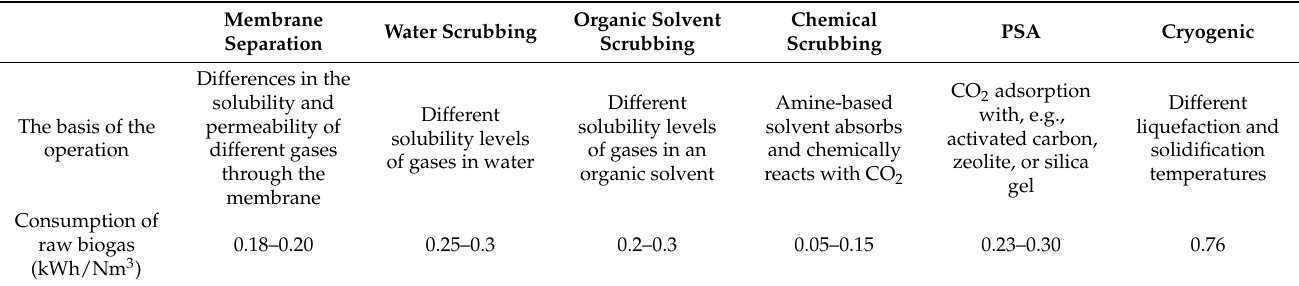
Table 2. Comparison of different biogas upgrading